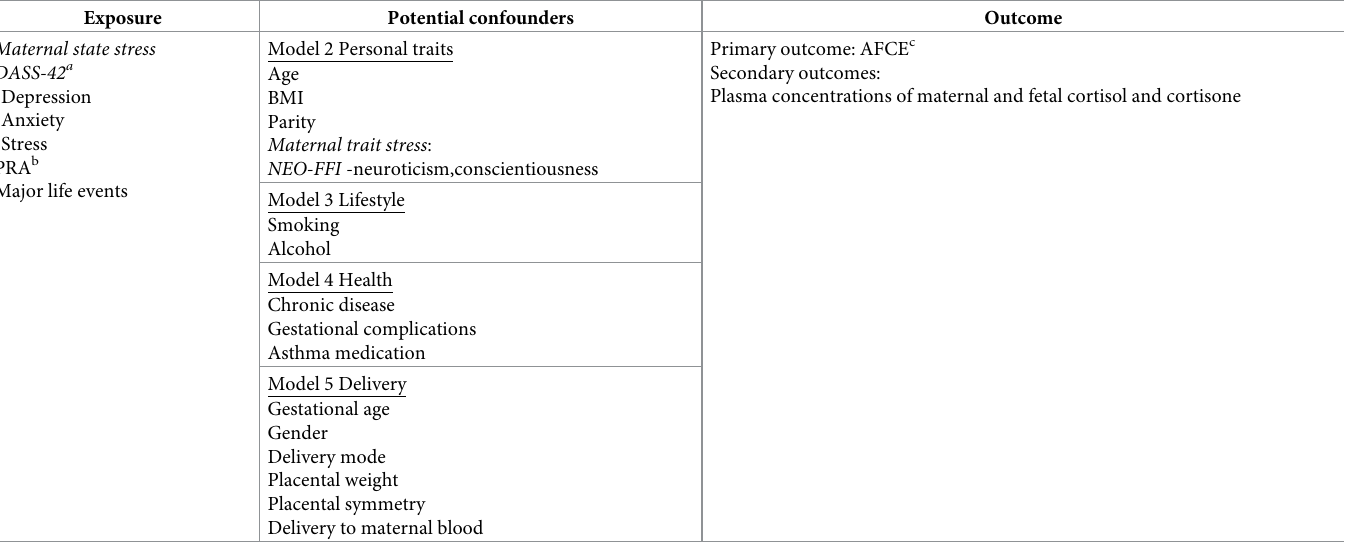
Table 1. Epidemiological model including exposures, potential confounders and outcome